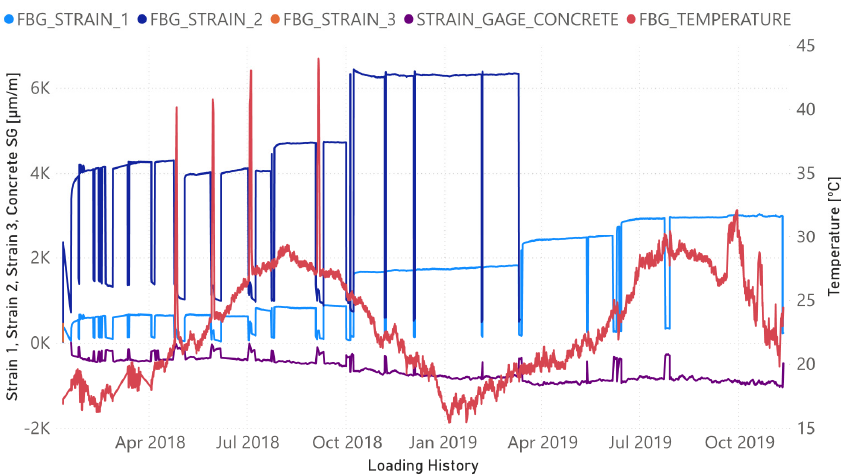
Figure 4. Evolution of tensile and compressive strains and temperature along the loading history.